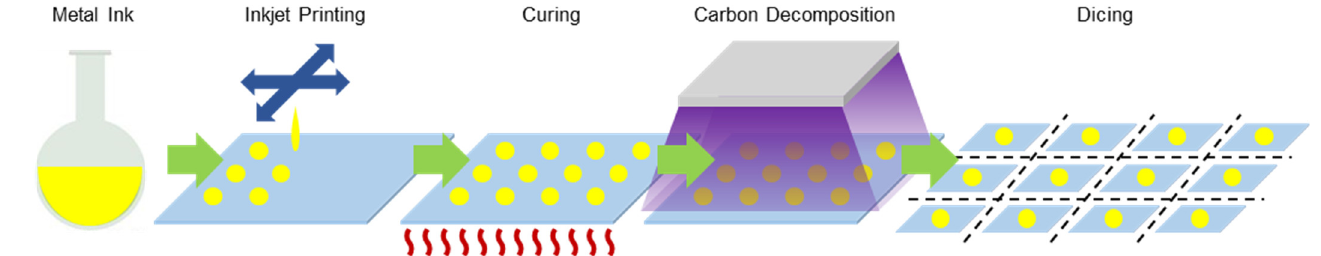
Figure 2. Fabrication steps for the tattoo paper-based AgNP SERS substrates.